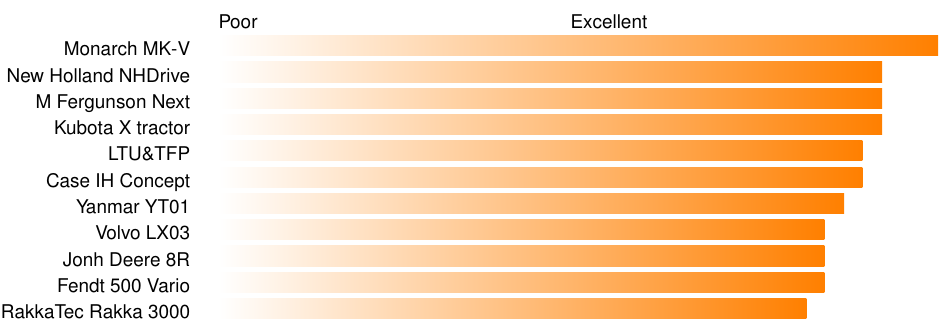
Communications Figure 10. MIM overall evaluation: control, perception and communications KPIs. Poor Excellent Monarch MK-V Volvo LX03 Fendt 500 Vario M Fergunson Next Case IH Concept New Holland NHDrive Kubota X tractor Jonh Deere 8R LTU&TFP AgXeed AgBot